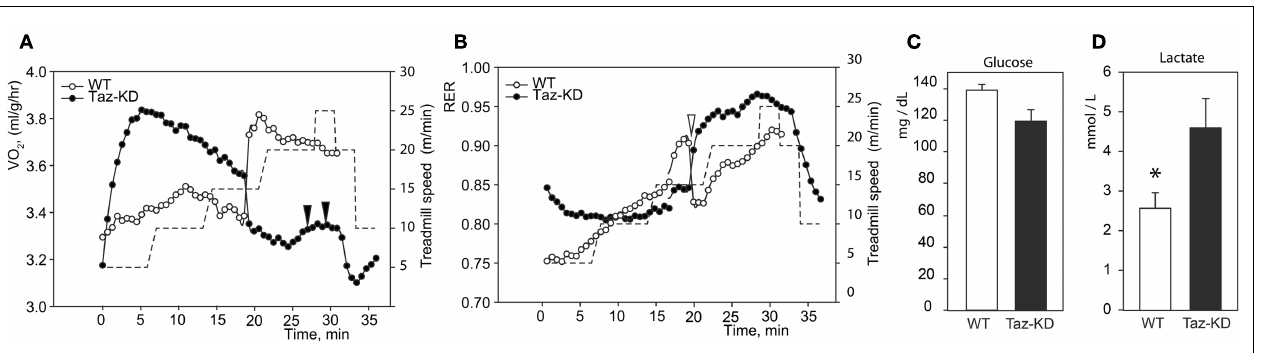
FIGURE 2 | Representative recordings of physiological parameters of Taz-KD andWT mice during forced exercise on a treadmill. (A,B) O 2 consumption rate and respiration exchange ratio (RER) were monitored continuously during the entire session of forced exercise.Taz-KD mice repeatedly failed to stay on treadmill [black arrowheads on (A) ], whileWT controls remained on the treadmill belt during the entire test. Sudden